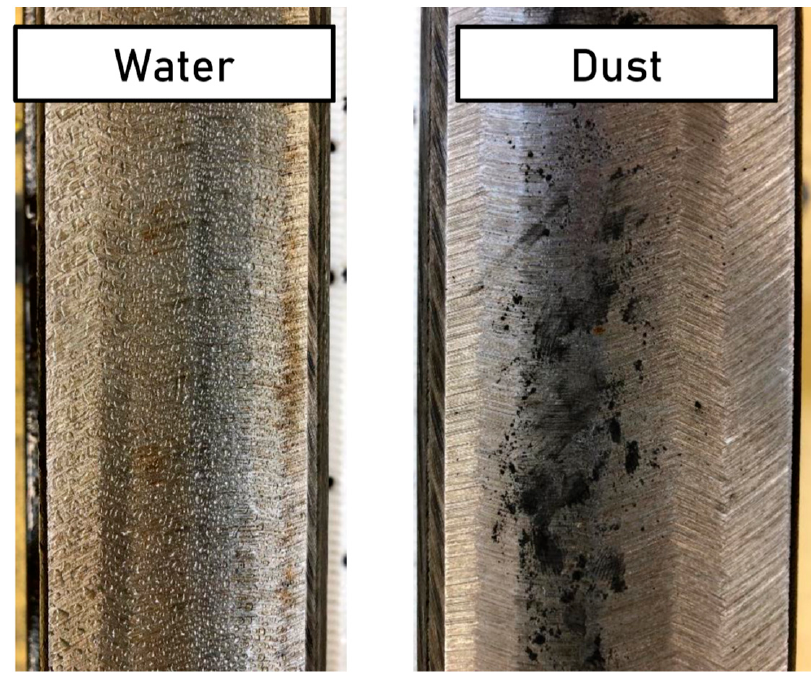
Figure 2. Water and dust on the rail surface.